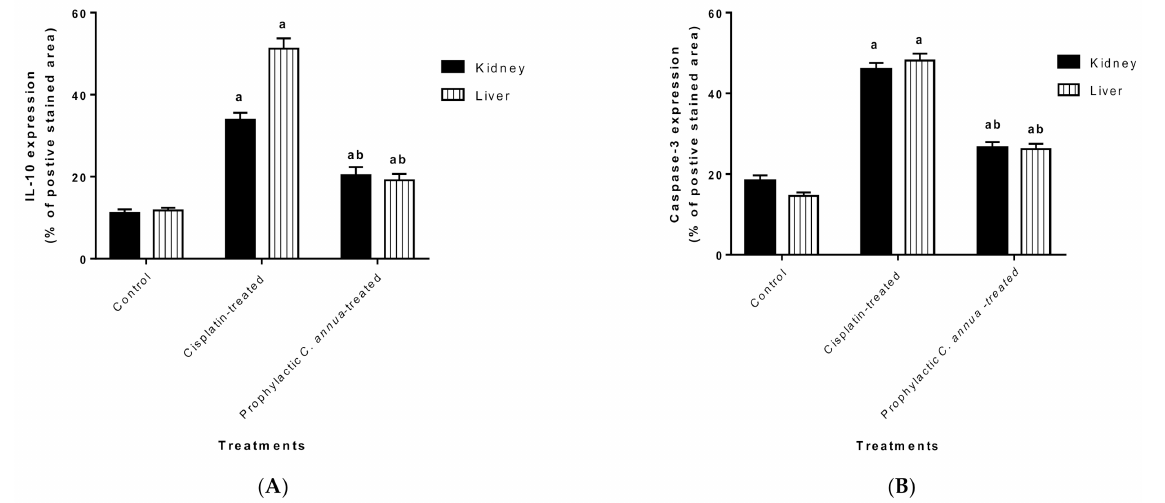
Figure 5. ( A ) Level of IL-1 β expression in liver and kidney tissues of the experimental groups. Positive proportions of IL-1 β expression were increased significantly in liver and kidney of cisplatin treated rats compared to the normal control and C. annua pretreated group. ( B ) Level of caspase-3 expression in liver and kidney tissues of the experimental groups. Positive proportions of caspase-3 expression were elevated remarkably in liver and kidney of cisplatin treated rats compared to the normal control and C. annua pretreated group. Data are represented as mean ± SE and analyzed using ANOVA followed by Bonferroni’s post-hoc test at p value < 0.05, n = 15 for each group. a indicates the presence of significant difference from normal control group, b indicates the presence of significant difference from cisplatin